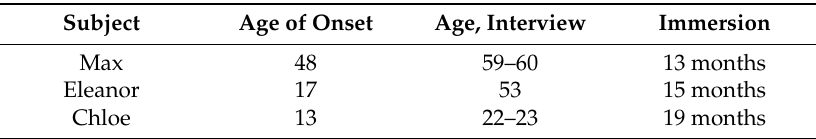
Table 2. Characteristics of